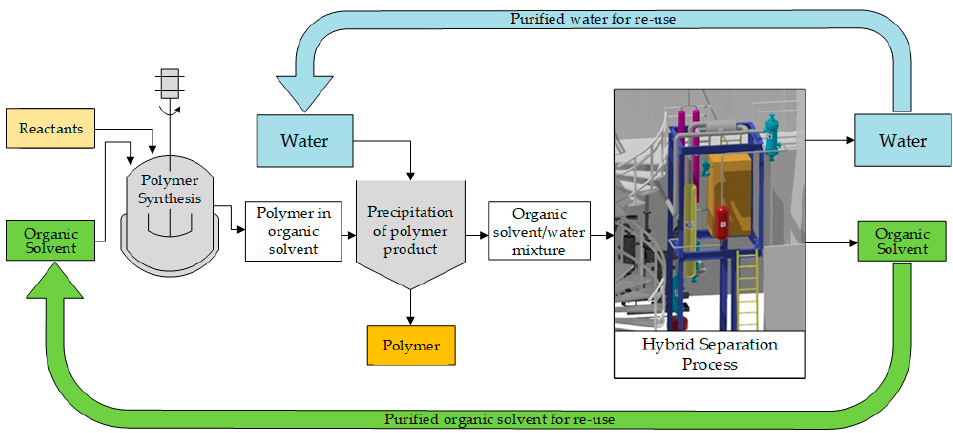
Figure 1. Scheme of a closed-loop process for the purification of a mixture of organic solvent and water resulting as waste product from the synthesis of polymers and their subsequent precipita- tion.